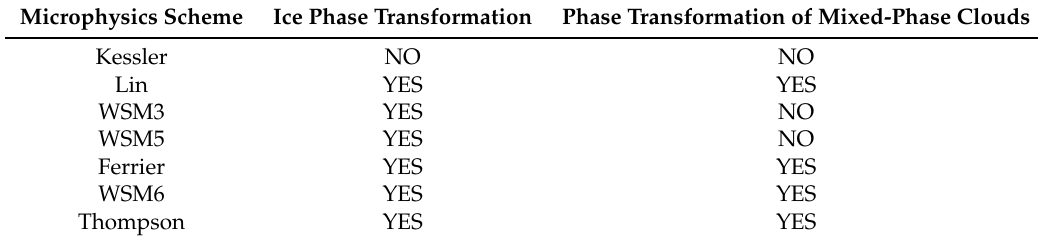
Table 5. Differences in microphysics schemes.